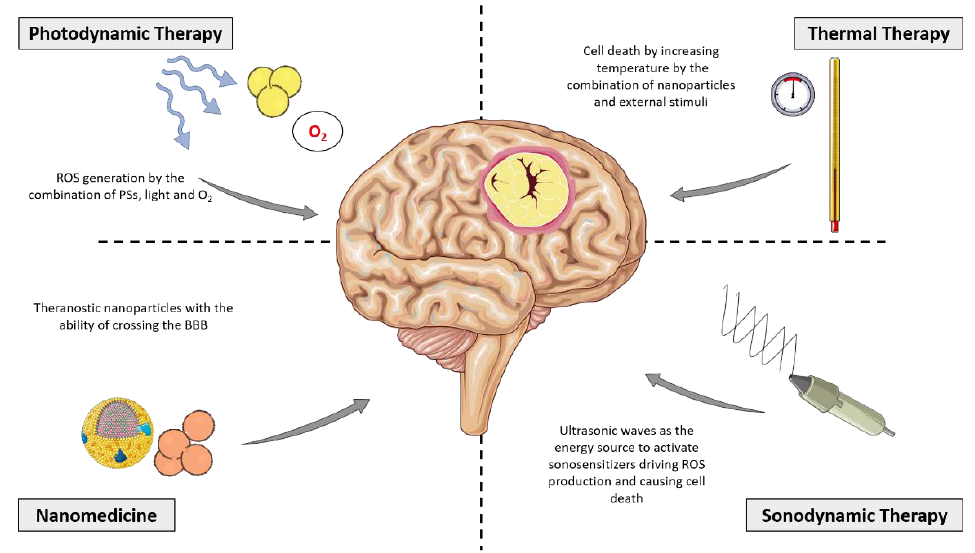
Figure 5. Alternative treatment modalities for GBM. Non-standard treatment options for GBM patients with the main mechanisms of action are represented by solid straight lines. This figure was created using Servier Medical Art templates, which are licensed under a Creative Commons Attrib- ution 3.0 Unported License; https://smart.servier.com (accessed on 1 February 2023).